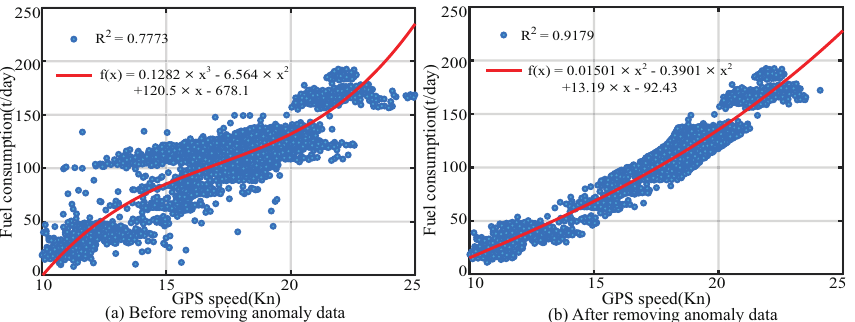
Figure 1. Effect of data processing on the ship fuel consumption data: ( a ) Before removing anomaly data. ( b ) After removing anomaly